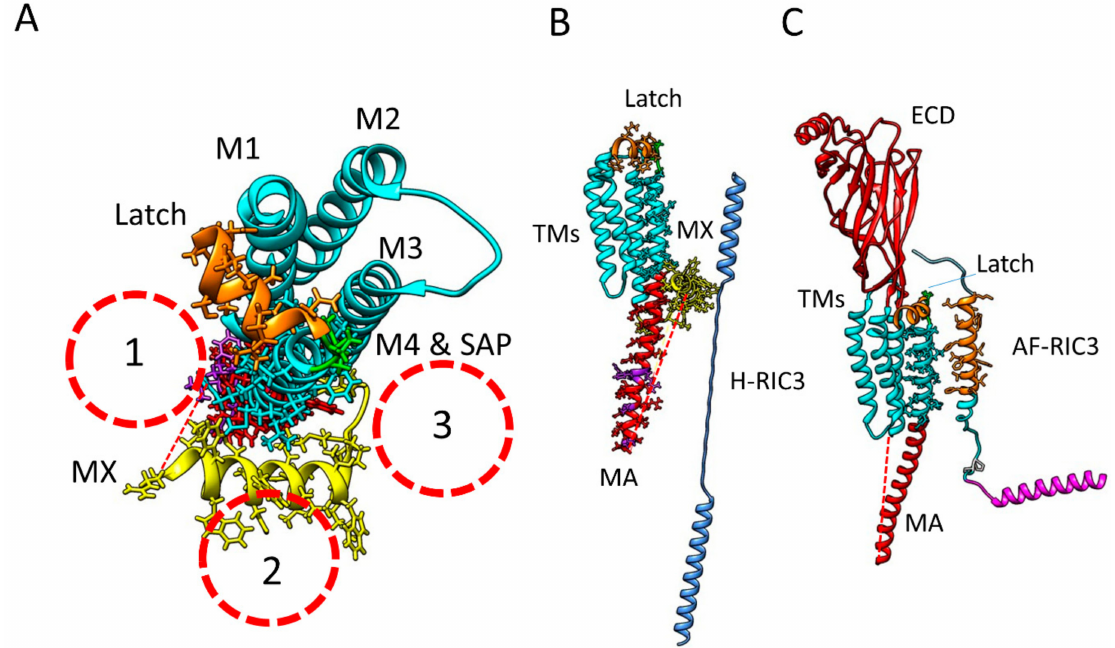
Figure 7. Locations where the RIC-3 transmembrane domain may contact an alpha7 receptor subunit. ( A ). Three locations where the RIC-3 TMD could make contact from a top view. The inside diameters of the dotted circles approximate the size of an alpha helix with the amino acid side chains. ( B ). Side view of how MX would block hyperextended RIC-3 from contacting alpha7-TMs. ( C ). The same view (but including the ECD) if AlphaFold RIC-3 contacted alpha7 M4 before MX is folded into place. A short piece (10 amino acids, 60% glycine) of the RIC-3 intraluminal strand is included at the N-terminal (extracellular) side of RIC-3 TM, and the N-terminal intraluminal remainder could easily contact unknown locations on the extracellular domain of the